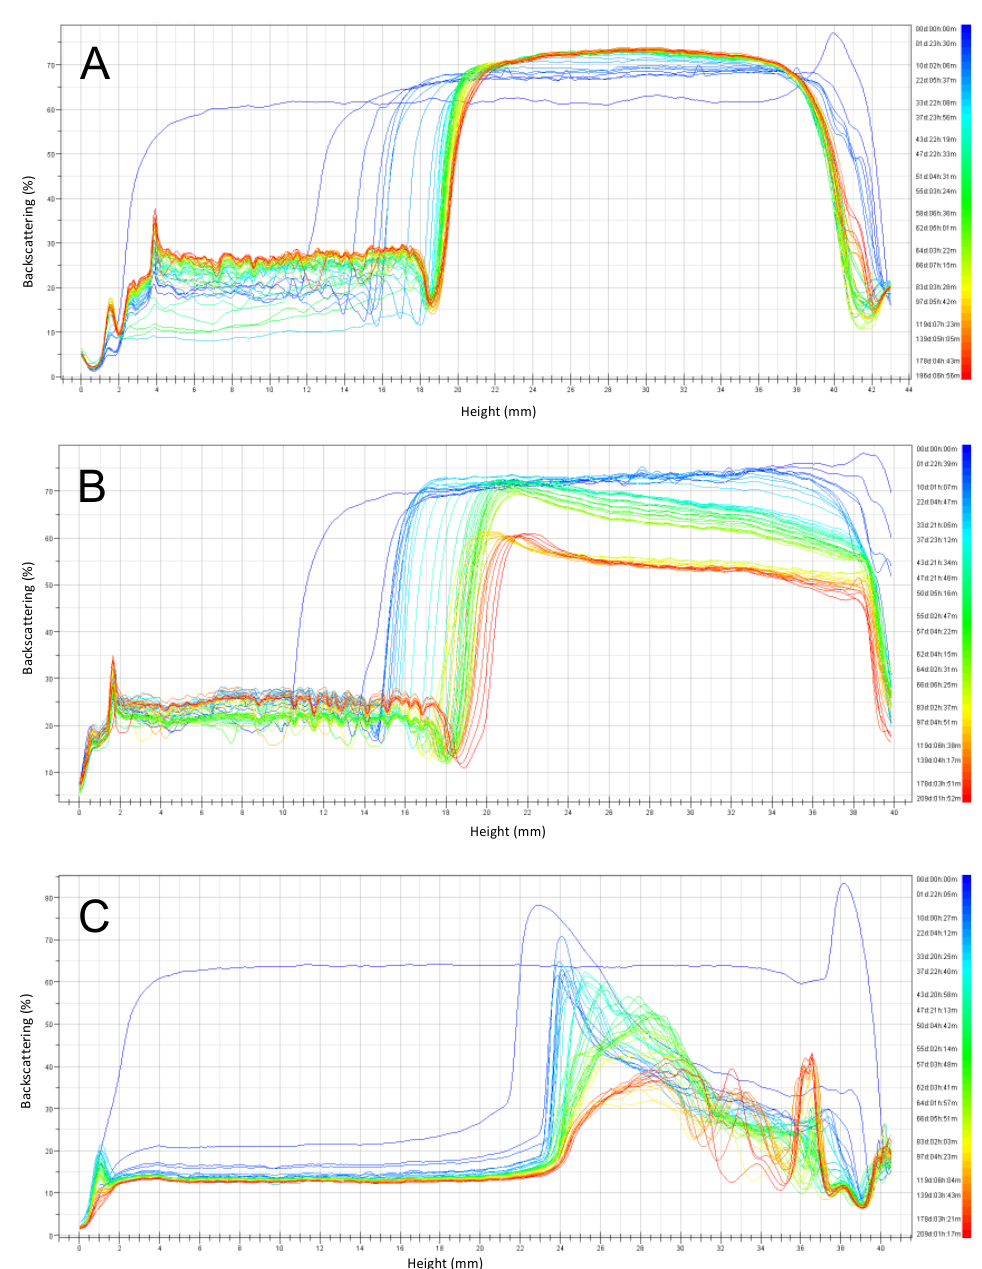
Figure 5. Backscattering profiles of emulsions prepared at pH 6 and stored six months at 4 °C. ( A ) Emulsions stabilized by rapeseed protein precipitated at pH 3 (RPP3), ( B ) Emulsions stabilized by rapeseed protein precipitated at pH 6.5 (RPP6.5), ( C ) Emulsions stabilized by soy lecithin. A similar trend was observed for emulsions prepared at pH 6 stored at 30 C (Figure 6), but the instability observed was larger compared to storage at 4 °C. The emulsions stabilized by RPP3 presented reasonable stability during the six months of storage since only a clarification layer was observed. In the case of emulsions stabilized with RPP6, a large instability was observed after two months of storage by the presence of three differ ‐ ent phases: a clarification layer at the bottom part of the cell, an emulsion phase in the middle, and the presence of free oil with some free protein at the top part of the cell. For emulsions formulated with soy lecithin, a similar behavior as for RPP6 was observed from the first day of the monitoring time.